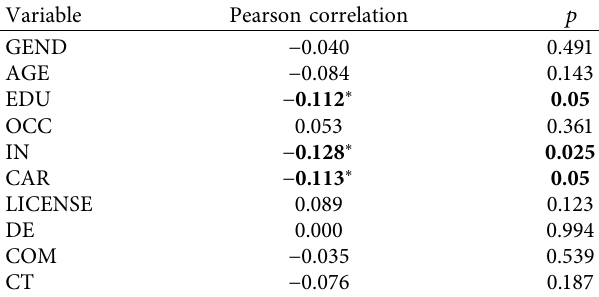
Table 4: Correlation analysis